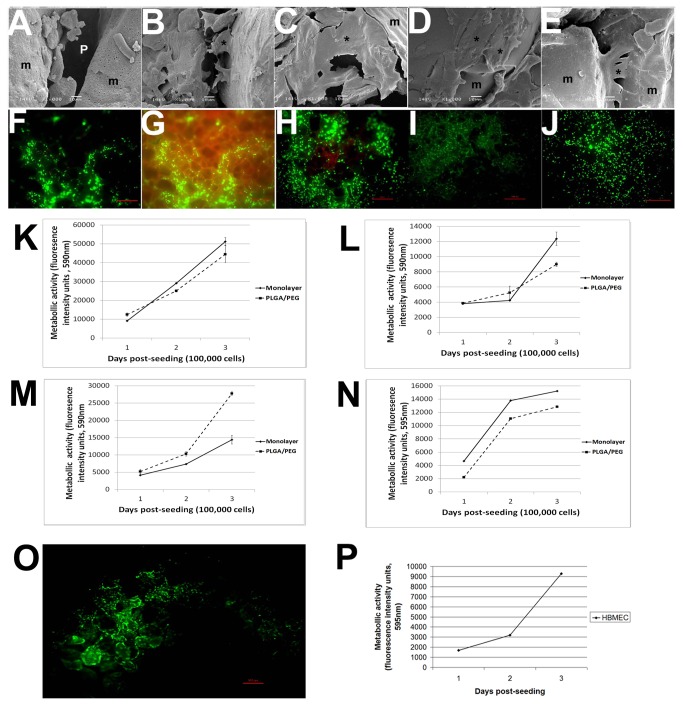
Assessment of PLGA/PEG microparticle-based matrix toxicity to normal and cancerous cells.To address toxicity of polymer matrices, brain cancer cells were grown on PLGA/PEG matrices. (A) Scanning electron microscopy images of blank PLGA/PEG matrices with distinct microparticles (m) and pores (p). (B-E) PFSK-1 (CNS PNET), DAOY (medulloblastoma), C6 (rat glioma) and U87 (glioblastoma multiforme) brain tumor cells cultured on PLGA/PEG matrices for 3 days. Cells exhibit 3D morphology both across microparticle faces and between microparticles, with extra cellular matrix visible. Representative tumor cells are denoted with an asterisk. Magnifications x1000. (F) Live/Dead assay of PFSK-1 cells demonstrates that ~85% of cells are viable. (G) Image of PFSK-1 cells without adjustment of background fluorescence, with visible microparticles (background fluorescence from particles is reddish-brown). (H-J) Live/Dead assay of DAOY, C6 and U87 cells demonstrates that 85%-100% of cells are viable. All images are shown on culture day 3 post-seeding onto matrices. Green = viable; Red = non-viable. Scale bar = 100µm. (K-N) Alamar Blue proliferation assay for PFSK-1, DAOY, C6 and U87 respectively, over a 3-day culture period post-seeding onto PLGA/PEG matrices and compared to 2D monolayer cultures of the same cell lines. The proportion of proliferating cells was inferred indirectly from a measurement of metabolic activity. Error bars represent the standard error of the mean from three independent matrices and over three independent experiments. Unpaired t-test analyses reveals no significant differences between the two culture systems (O-P) Viability and proliferation of brain endothelial cells (HBMEC) over a 3-day culture period post-seeding onto PLGA/PEG matrices Green = viable; Red = non-viable. Scale bar = 100µm.